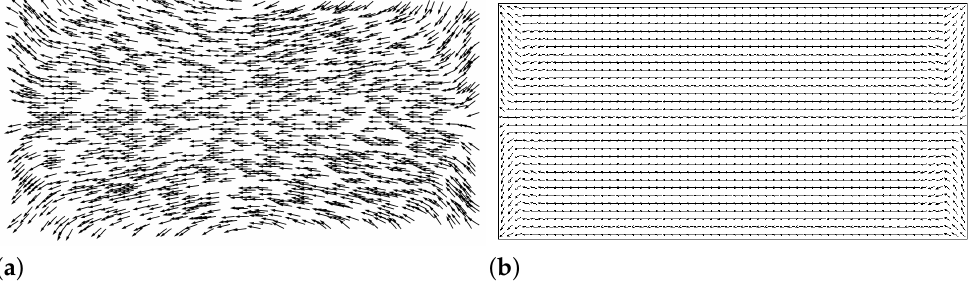
Figure A1. Distribution of the remanent magnetization vector after applying the magnetic field parallel to the long axis: ( a ) obtained by us, ( b ) lu96a.